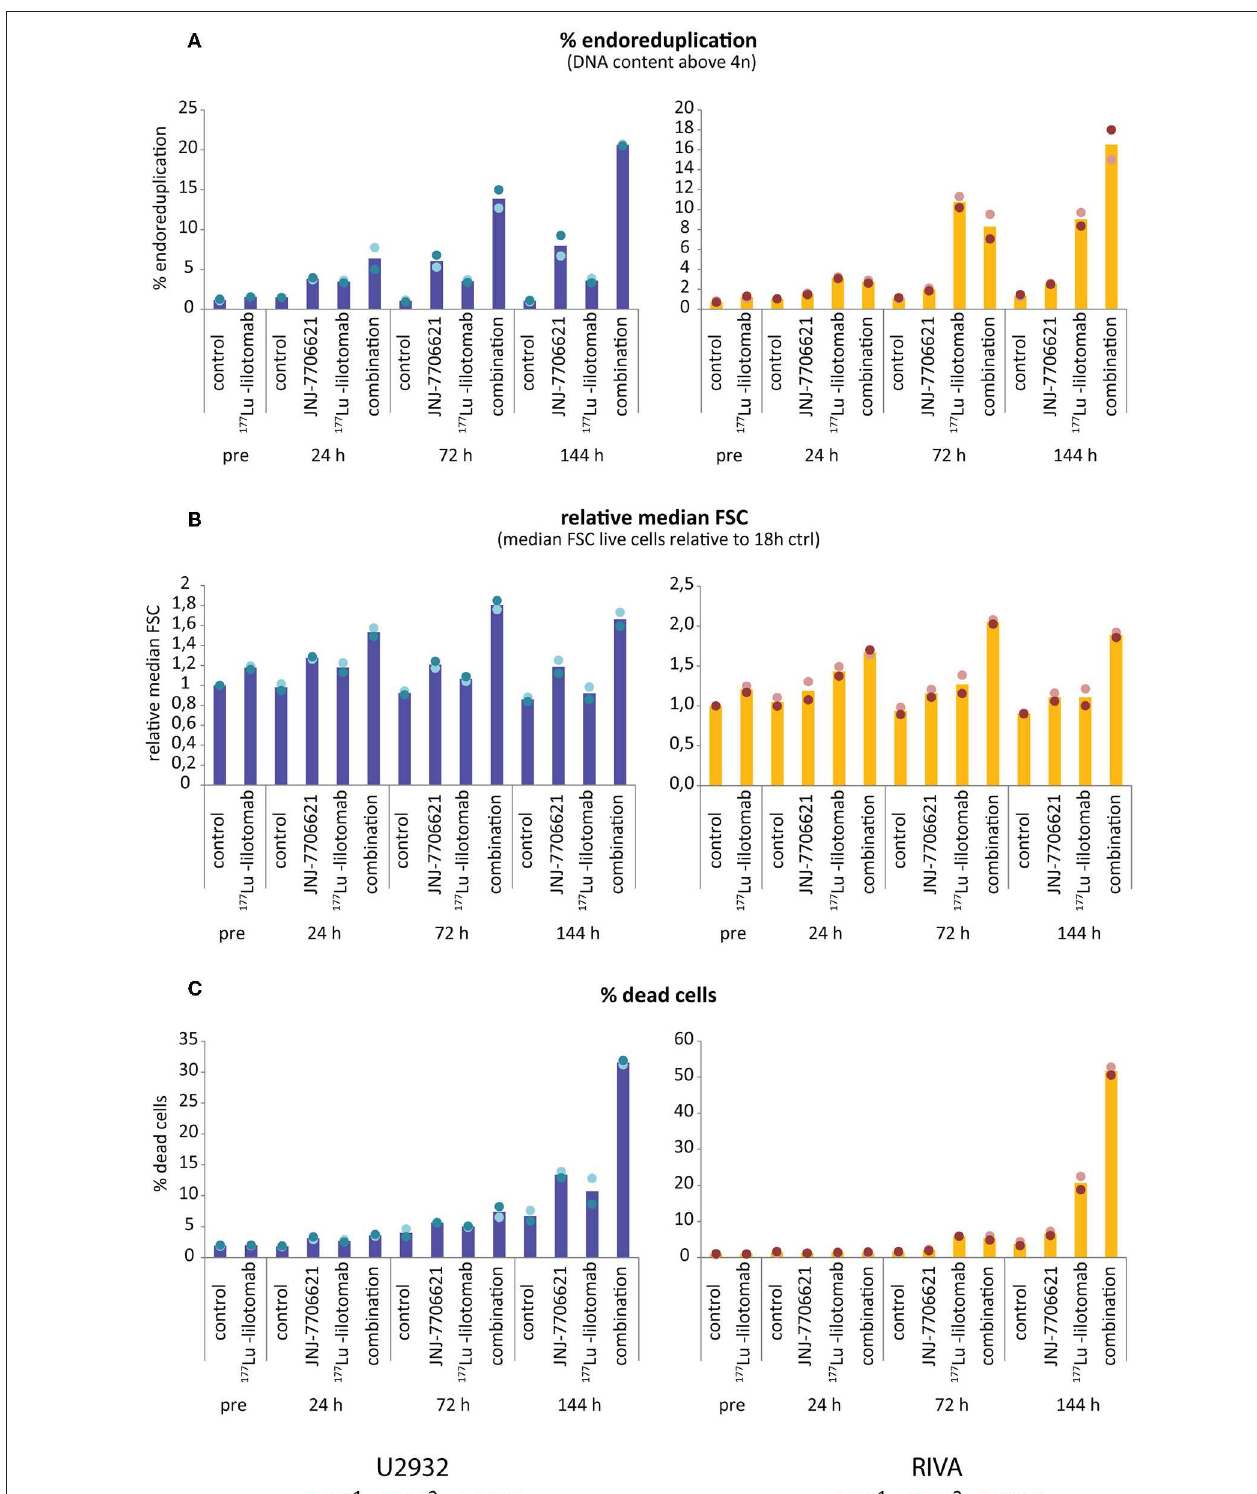
FIGURE 6 | Increase in > 4n population and cell size precedes cell death upon combined treatment with JNJ-7706621 and 177 Lu-lilotomab satetraxetan. Results are from the same experiment as in Figure 5 and a parallel experiment. (A) Percentage of cells with DNA content above 4n. (B) Median forward scatter (FSC) of live cells (gated on Pacific Blue channel), all values are relative to untreated control of 18h pre-treatment. (C) Percentage of dead cells as measured by Pacific blue staining. Bar diagrams show mean of two separate experiments, with individual data indicated with dots. Left panels: U-2932, right panels: RIVA.